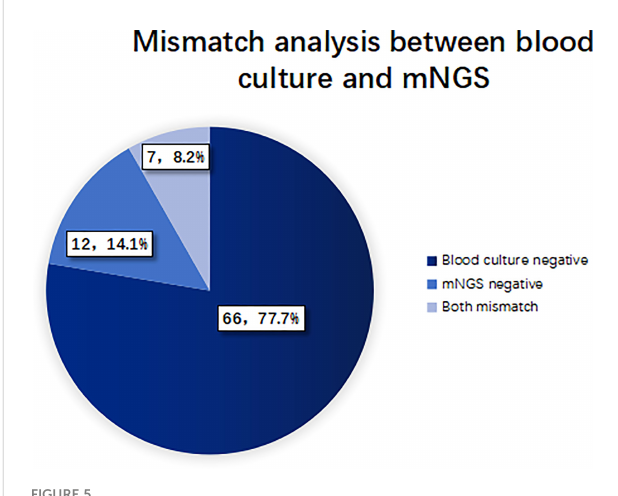
FIGURE 5 Inconsistency analysis of pathogens detected by blood culture and